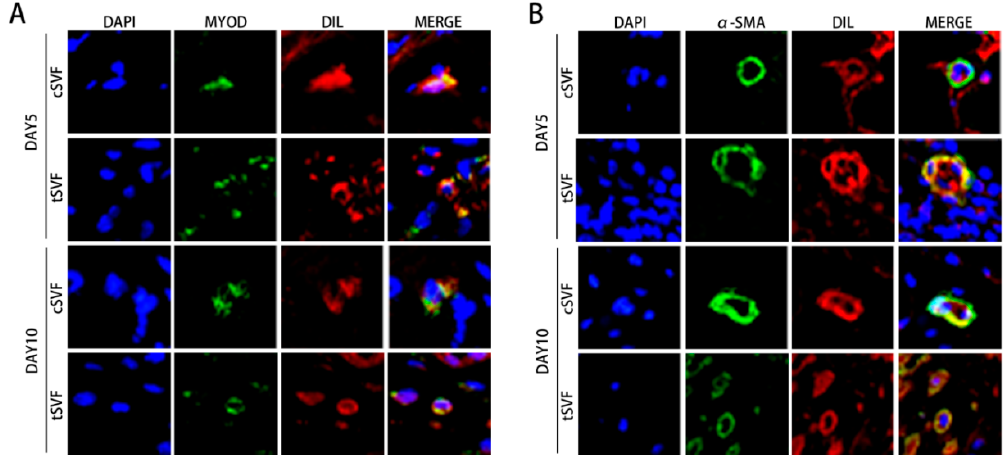
Figure 9. CSVF and tSVF differentiated into myosatellite cells and smooth muscle cells in vivo. Some Dil-labeled cells expressing MYOD ( A ) or α -SMA ( B ) were detected in the cSVF and tSVF groups on days 5 and 10 after treatment. MYOD: myogenic differentiation factor D, α -SMA: α smooth muscle actin.